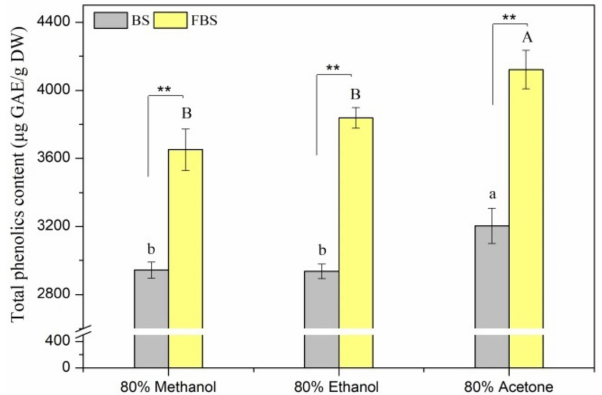
Figure 1. Total phenolics content (TPC) of the various extracts from non-fermented black soybeans (BS) and E. cristatum -fermented black soybeans (FBS). Values followed by different capital letters or small letters are remarkably different ( p < 0.05) among the different solvent extracts of FBS or BS, respectively. The symbols (**) denoted a significant difference at a level of 0.01 between FBS and BS regards the same extracted